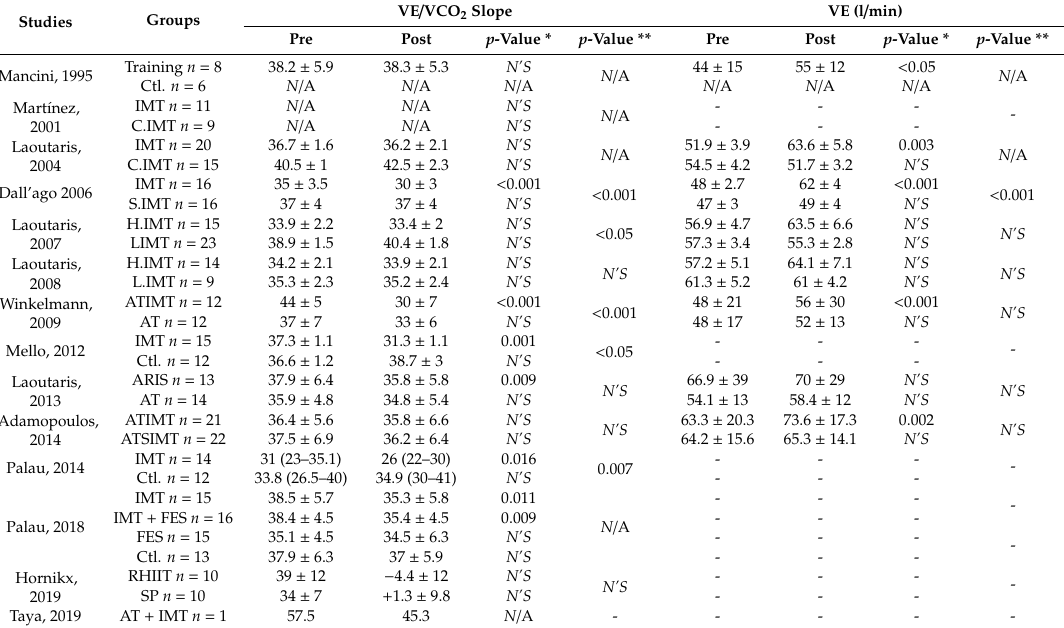
Table 6. Ventilation per minute (VE) / VCO 2 and